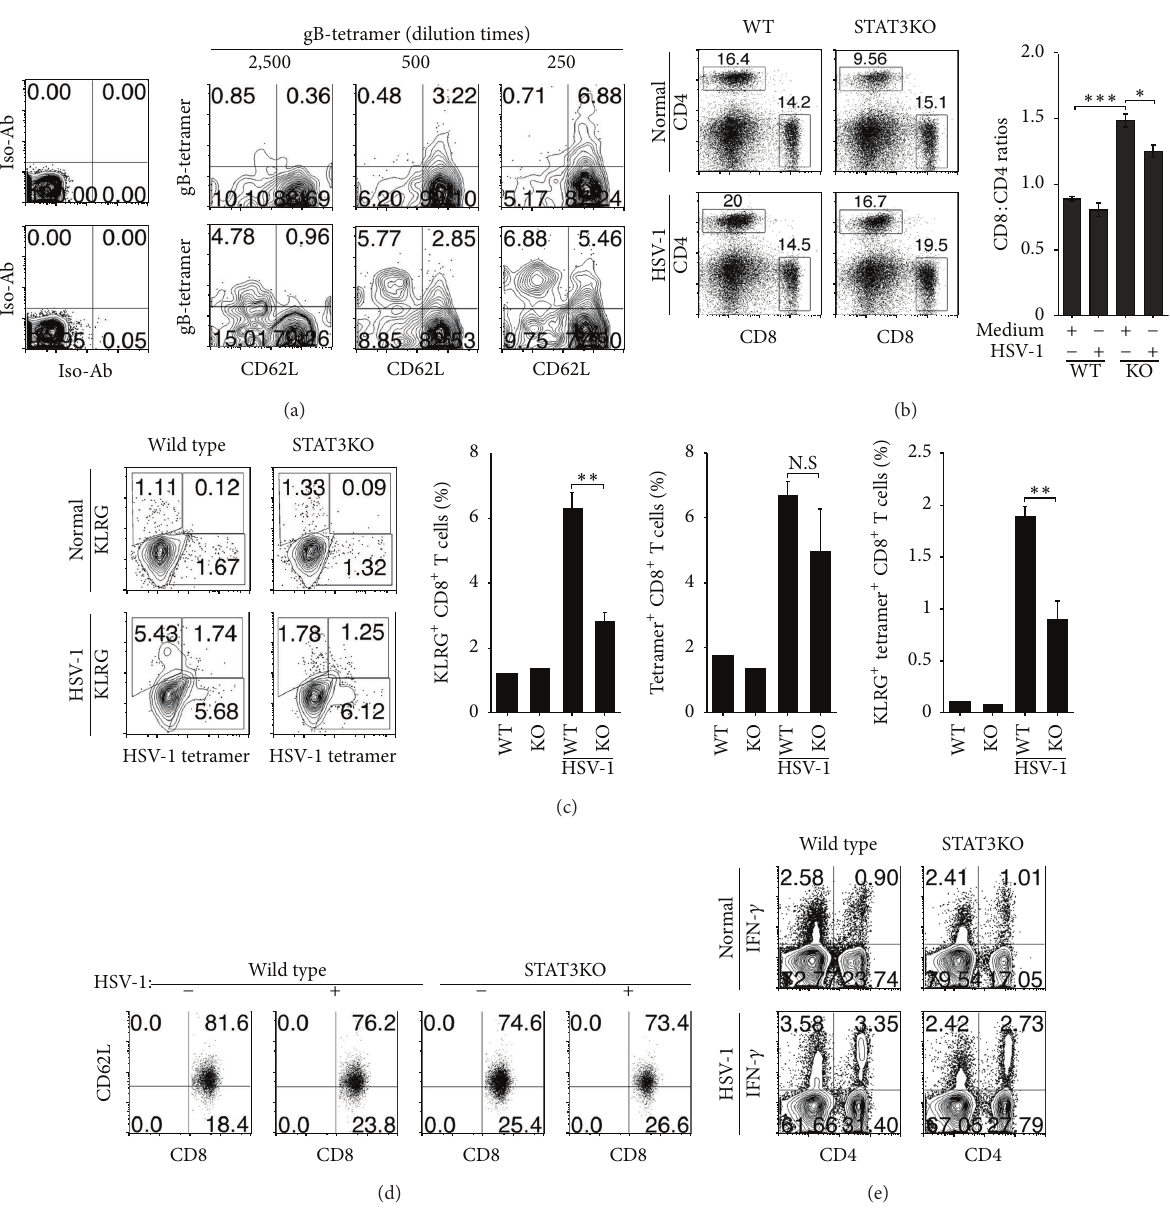
Figure 4: STAT3KO mice are defective in generating HSV-1 specific CD8 + effector T cells in response to HSV-1 infection. (a–d) C57BL/6 mice were infected with HSV-1, and immune response to the virus was assessed by FACS analysis. (a) Virus-specific response was established and assessed in the WT mouse by FACS using gB-tetramers. (b–d), Analysis of CD4 + and CD8 + T cell responses to HSV-1 (b), activated virus-specific CD8 + T cells (c), and IFN- 𝛾 production by the HSV-1-specific CD4/CD8 T cells (d). Cells were gated on CD8 (a, c) or CD3 (b, d), and numbers in quadrants represent percentage of tetramer positive CD8 + T cells or T cells expressing KLRG, CD62L, CD4, CD8, or IFN- 𝛾 . Data represent at least 3 independent